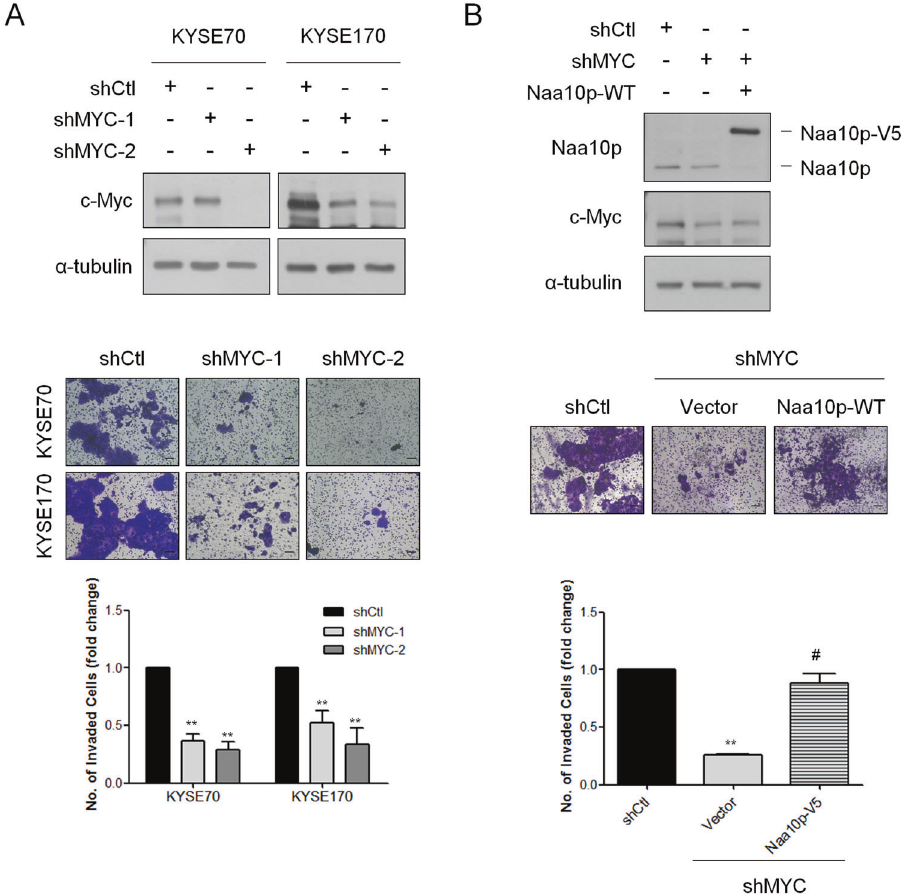
Fig. 6 Naa10p mediates c-Myc-induced cell invasiveness. A Upper, suppression of c-Myc by shRNAs in KYSE70 and KYSE170 cells were con fi rmed by immunoblotting analysis. Middle, representative views of cells in the transwell invasion assay. Lower, quanti fi cation of cells that invaded through a Matrigel-coated membrane following transfection of Ctl-shRNA or MYC -shRNAs. Bars are the mean ± SD of three independent experiments. ** P < 0.01 when compared to shCtl group by two-tailed Student ’ s t test. Scale bar: 100 μ m. B Upper, immunoblotting analysis of stably c-Myc-silencing KYSE70 cells transfected with either vector or Naa10p-V5. Lower, representative images and quantitative data comparing cell invasion of stably c-Myc-silencing KYSE70 cells transfected with either vector or Naa10p-V5. Bars are the mean ± SD of three independent experiments. ** P < 0.01 when compared to shCtl group and # P < 0.01 when compared with sh MYC -vector cells by two-tailed Student ’ s t test. Scale bar: 100 μ